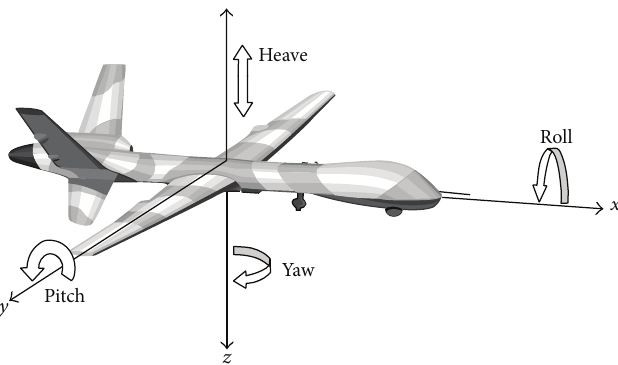
Figure 18: The degrees of freedom permitted by the Cranfield 4-DOF rig [101].